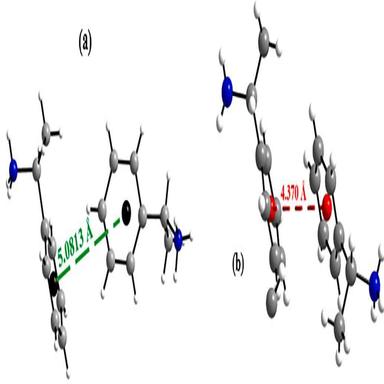
(a) C–H⋅⋅⋅π interactions between the aromatic rings of the organic moieties (b) Aromatic donor- acceptor interactions between the neighboring aromatic organic cations in (C8H12N)42.